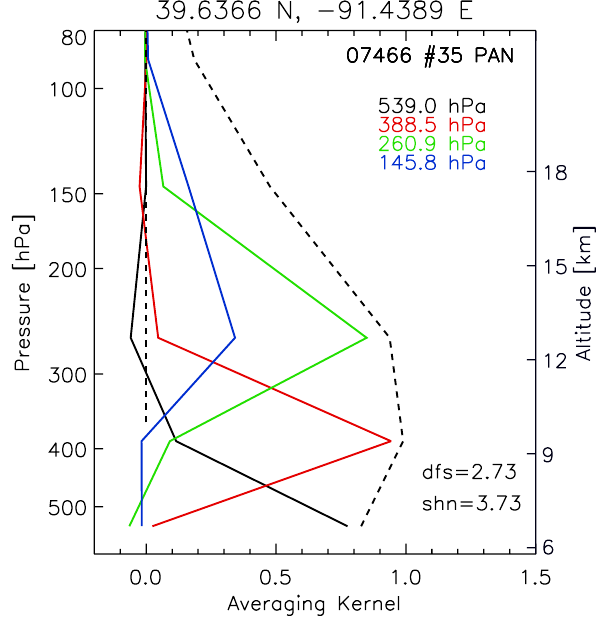
Fig. 3. a representative averaging kernel for a single mid-latitude PAN retrieval from orbit 07466, scan number 35 (from 4 August 2003, 41 ◦ N, 91 ◦ W). There are ∼ 2.7 degrees of freedom (dfs) for these measurements. The measurements also have 3.7 bits of shan- non information content (shn). The dashed black line represents the sum of the rows of the averaging kernel at each tangent altitude.